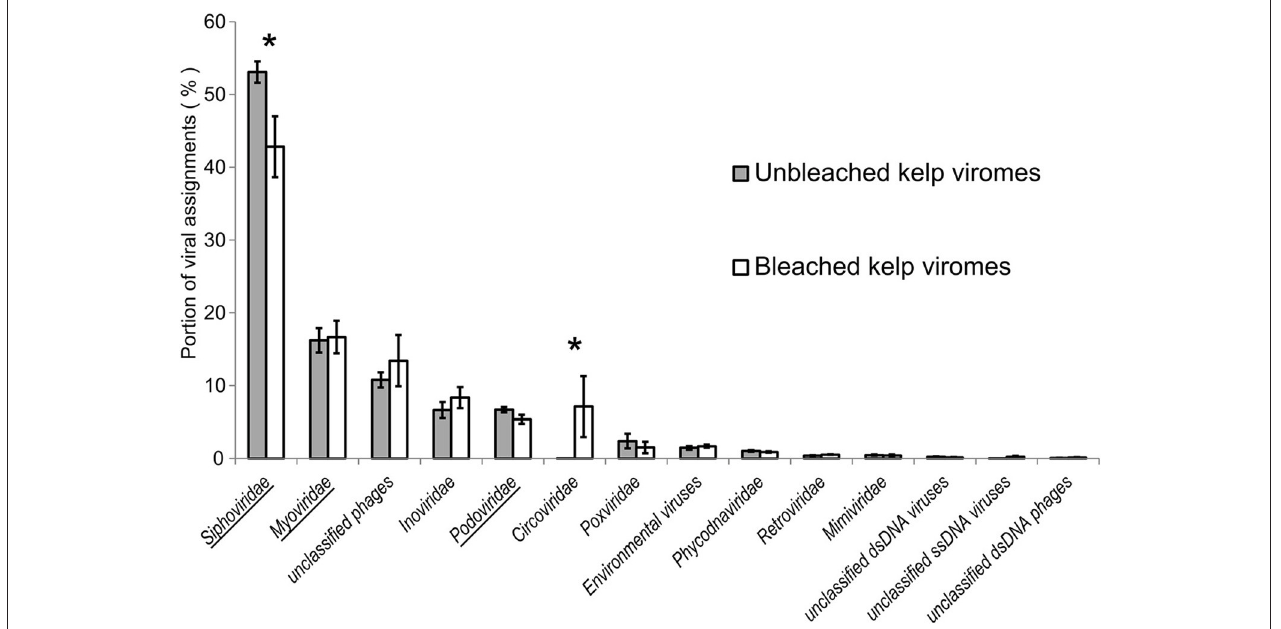
FIGURE 1 | Reads from viromes of bleached and unbleached kelps that were assigned to virus references. Bars are ± 1 standard error. Asterisk denotes an adjusted p-value < 0.005. Underlined taxa belong to the Caudovirales. Environmental viruses are annotated sequences from environmental metagenomes.